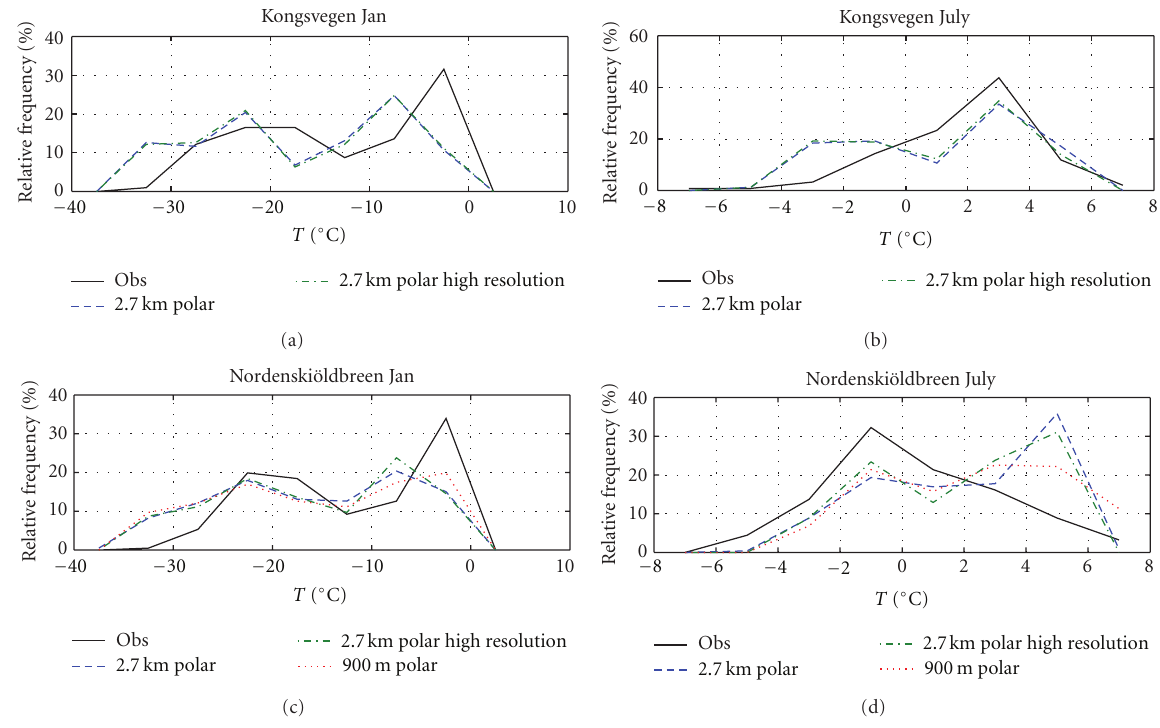
Figure 9: Frequency distribution of temperature at Kongsvegen and